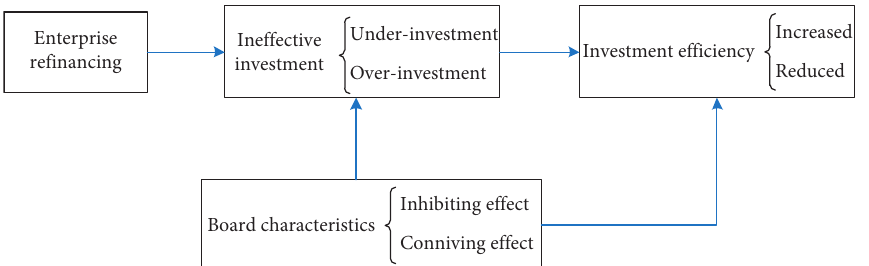
Figure 1: Influence mechanism of board of directors’ characteristics for refinancing companies based on investment